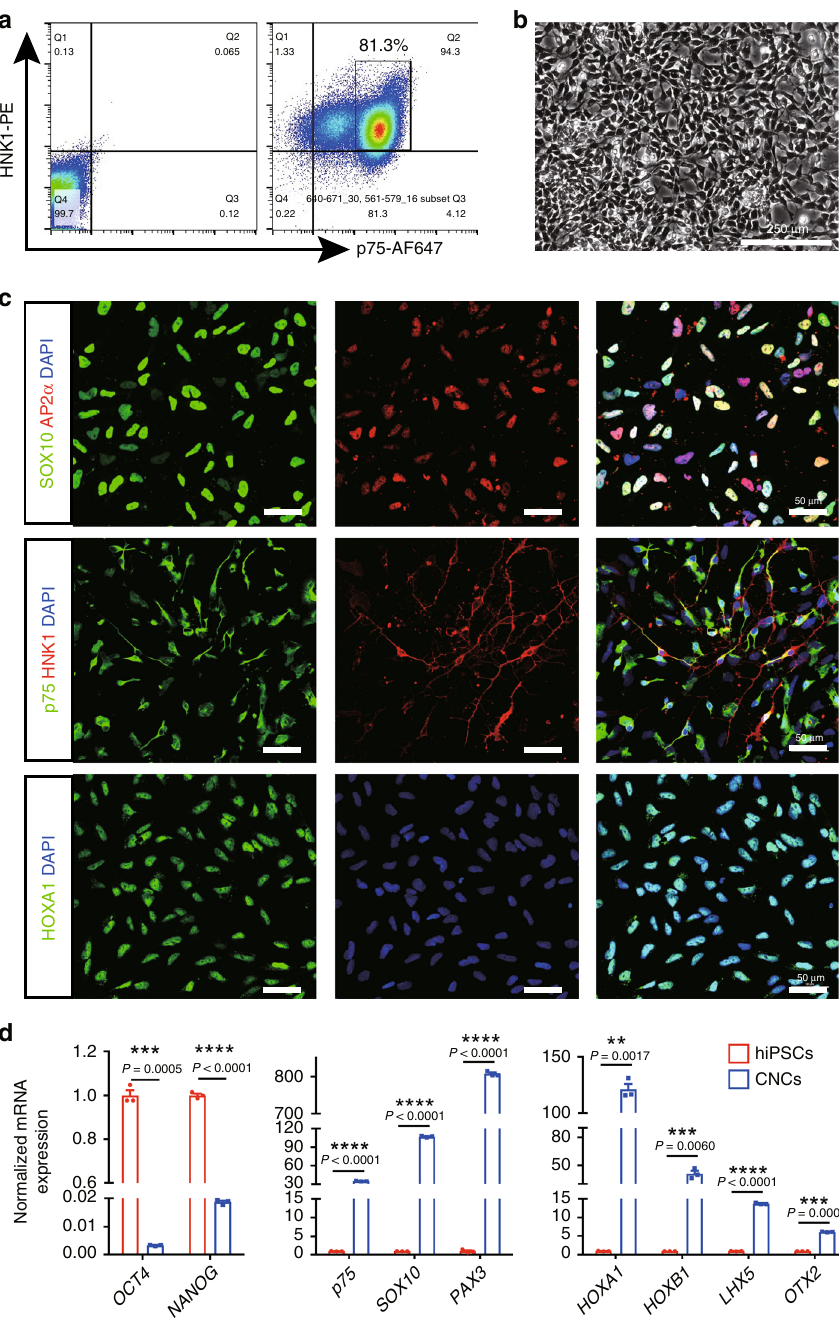
Fig. 1 Enrichment and characterization of cranial neural crest cells (CNCs) derived from hiPSCs. a CNCs (p75 bright HNK1 + cells) were isolated by FACS. b Enriched CNCs were cultivated in adherent monoculture and maintained typical neural crest morphology during in vitro culture. Scale bar: 250 μ m. c The expression of cranial neural crest-speci fi c markers (SOX10, AP2 α , p75, HNK1, HOXA1) in isolated cell was detected by immunostaining. Scale bar: 50 μ m. d The expression of pluripotency genes ( OCT4 , NANOG ), CNC markers ( p75 , SOX10 , PAX3 ), and cranial-speci fi c genes ( HOXA1 , HOXB1 , LHX5 , OTX2 ) in undifferentiated hiPSCs and CNCs was detected by qPCR. Graphs represent the individual data points, the mean ±SEM of three independent experiments. FACS analysis, Confocal and bright fi eld images are representative of n = 3 biological replicates. P -value (* P < 0.05, ** P < 0.01, *** P < 0.001, **** P < 0.0001) was calculated by two-tailed unpaired Student ’ s t -test. Source data are provided as a Source Data fi